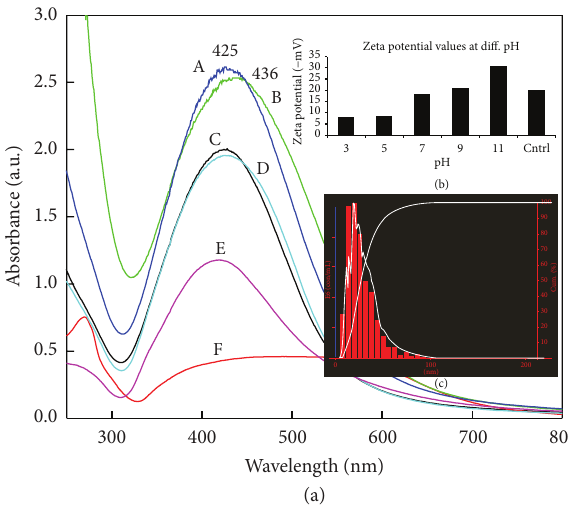
Figure 5: (a) UV-Vis extinction spectroscopy with the effect of pH on synthesis of SNPs. A. pH 9, B: pH 11, C: pH 7, D: control, E: pH 5,